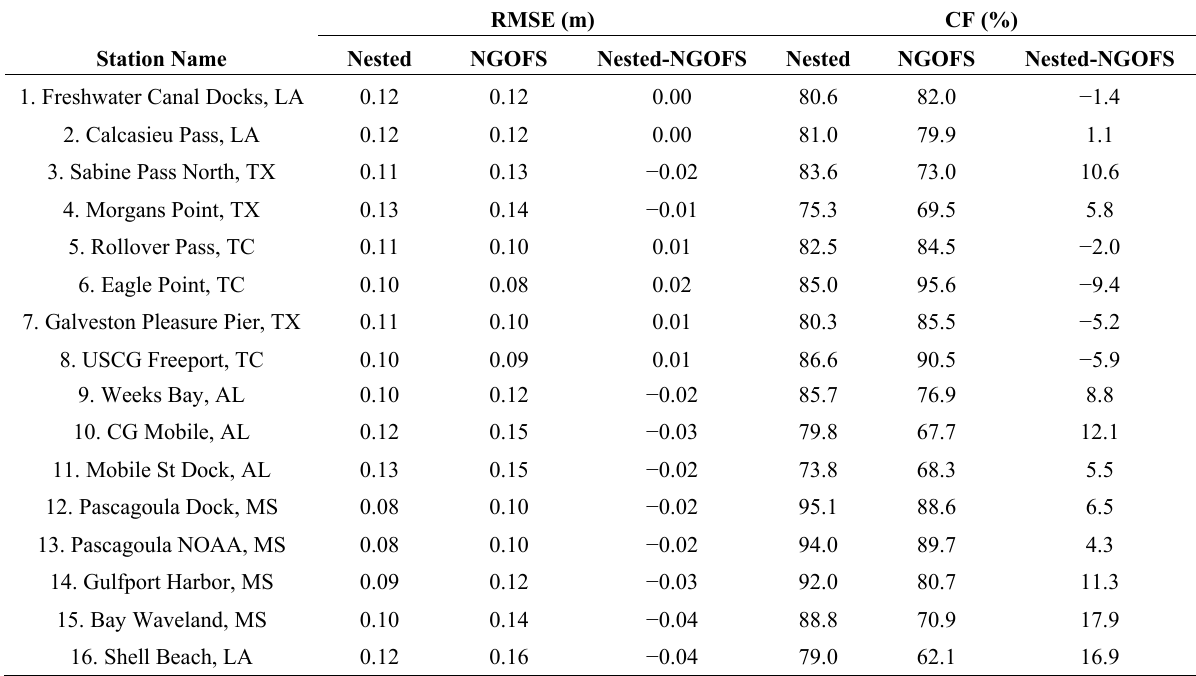
Table 1. Water level hindcast skill comparison between nested NGOFS and NGOFS. RMSE (m) CF (%)